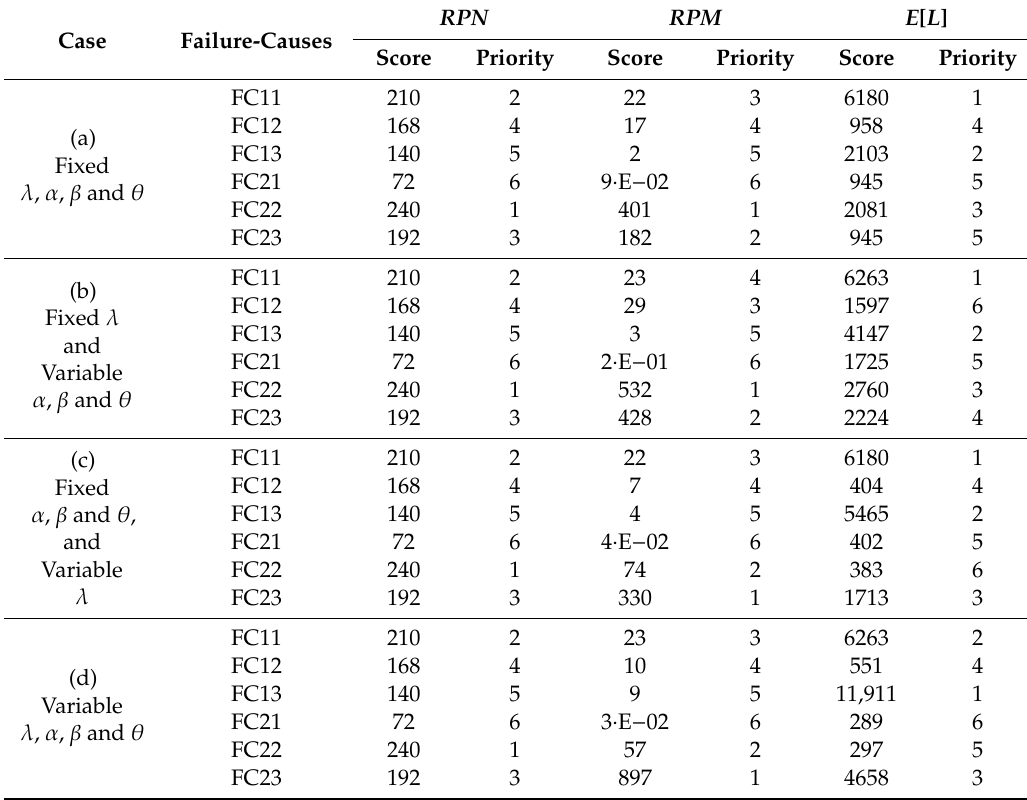
Table 3. Comparison between RPN of conventional FMEA model and RPM of TD-FMEA model for design FMEA: The priority of RPN and RPM is similar, so we may confirm the validity of the TD-FMEA model to some extent. ( ※ set µ and ε to the modified values in Table